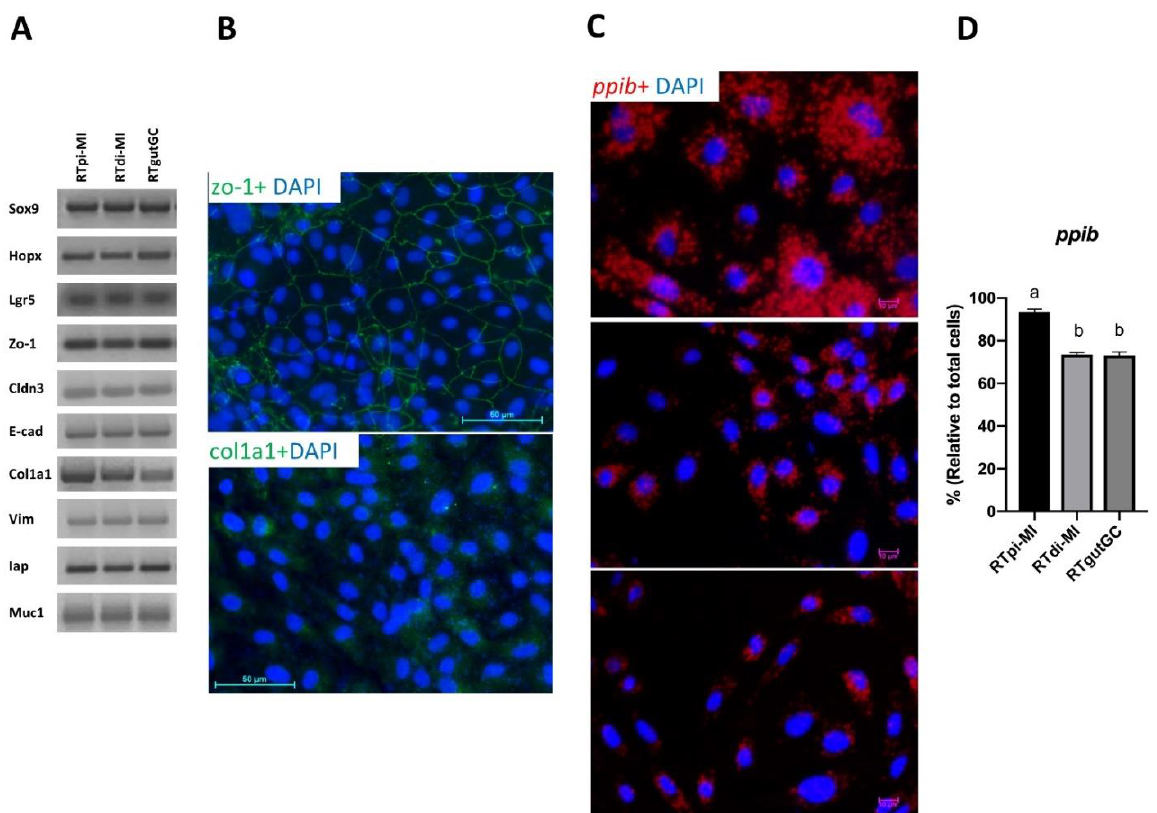
Figure 2. RTpi-MI, RTdi-MI and RTgutGC cell lines are composed of a heterogeneous population. ( A ) PCR amplicons of stem cell ( sox9 , hopx and lgr5 ), epithelial ( zo-1 , cldn3 and e-cad ) and connective tissue ( col1a1 and vim ), enterocyte ( iap ) and goblet cell ( muc1 ) genes in RTpi-MI, RTdi-MI and RTgutGC cell lines. ( B ) Representative immunofluorescence microphotographs showing zonula occludens (Zo-1, green, picture at the top) and collagen type 1 (Col1a1, green, picture at the bottom). DAPI (blue) was used to stain cell nuclei. Scale bar, 50 µm. ( C ) Representative immunofluorescence microphotographs showing the in situ hybridization of ppib (red) in RTpi-MI (picture at the top), RTdi-MI (picture in the middle) and RTgutGC (picture at the bottom). DAPI (blue) was used to stain cell nuclei. Scale bar, 10 µm. ( D ) Graphs reporting the percentage of ppib -expressing cells in RTpi-MI, RTdi-MI and RTgutGC cell lines. Data are reported as percentages (mean ± SD from 3 independent experiments) of ppib + cells on total cell count. Different superscript letters indicate statistical significance.